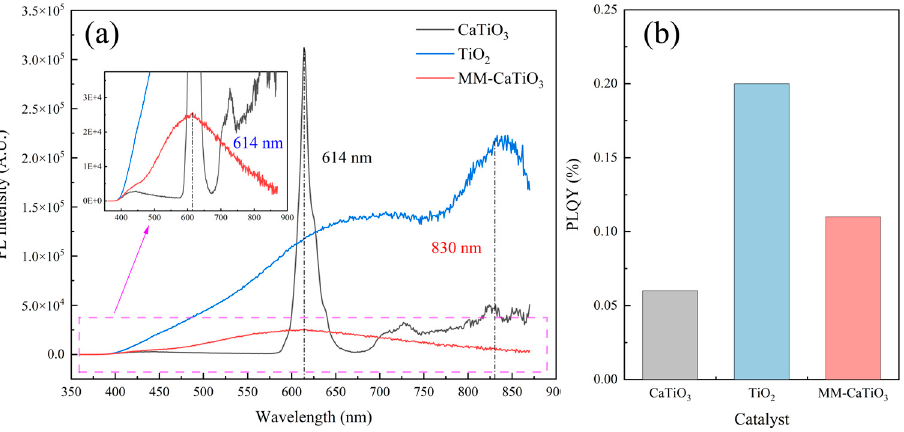
Figure 6. ( a ) The photoluminescence (PL) spectroscopy and ( b ) photoluminescence quantum yield (PLQY) analyses of catalysts. Table 2. The oxygen vacancy formation energy of CaTiO 3 (112) and (110) lattice plane.